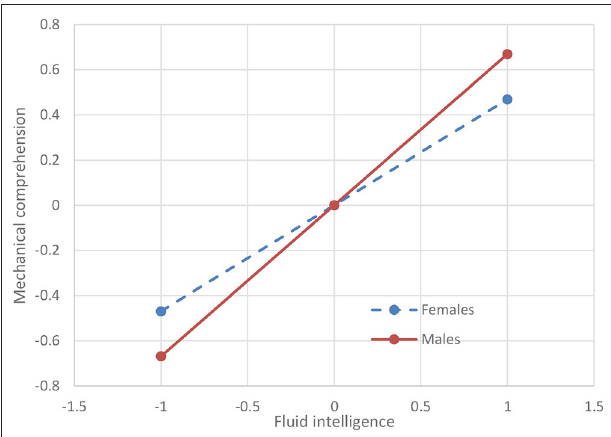
FIGURE 2 | The effect of fluid intelligence on mechanical comprehension for males and females. Both fluid intelligence and mechanical comprehension are expressed in Z